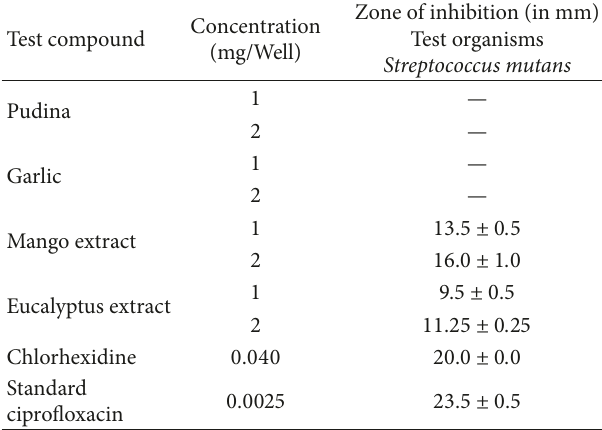
Table 1: Inhibitory activity of Test samples on Streptococcus